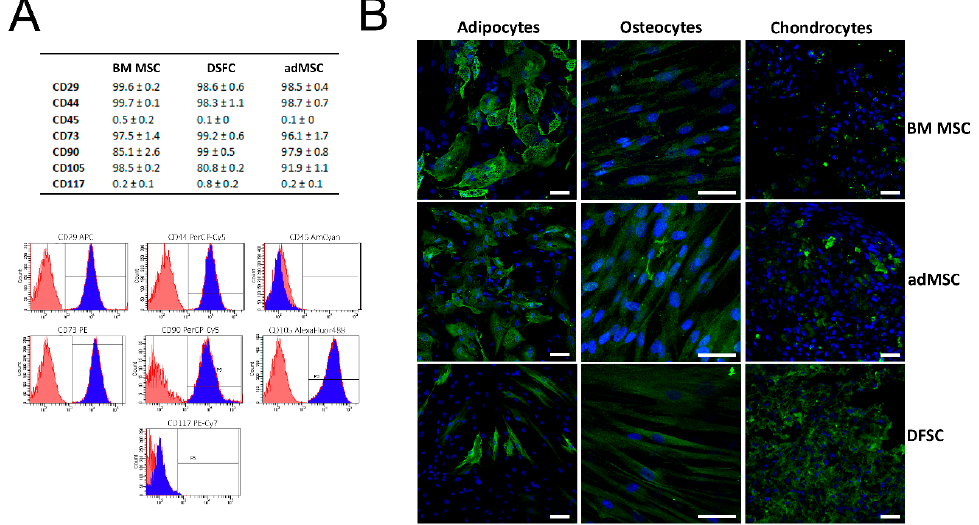
Figure 1. Phenotype-related and functional characterization of mesenchymal stromal cells (MSC): ( A ) Flow cytometric measurements revealed a high expression of common MSC surface markers (CD29, CD44, CD73, CD90, CD105), while very low levels were found for hematopoietic surface markers (CD45 and CD117). Representative flow cytometry charts of adipose tissue-derived MSC (adMSC) demonstrate the expression level of surface markers. Blue histograms represent measurement of CD surface marker with corresponding isotype control, shown in red. ( B ) Tri-lineage differentiation assay indicated adipogenic, osteogenic, and chondrogenic differentiation of MSC. Detection of adipocytes was performed by labelling of FABP4, while osteocytes and chondrocytes were identified by fluorescence staining of osteocalcein and aggrecan, respectively. Scale bar: 50 µ m. Results in ( A ) are shown as